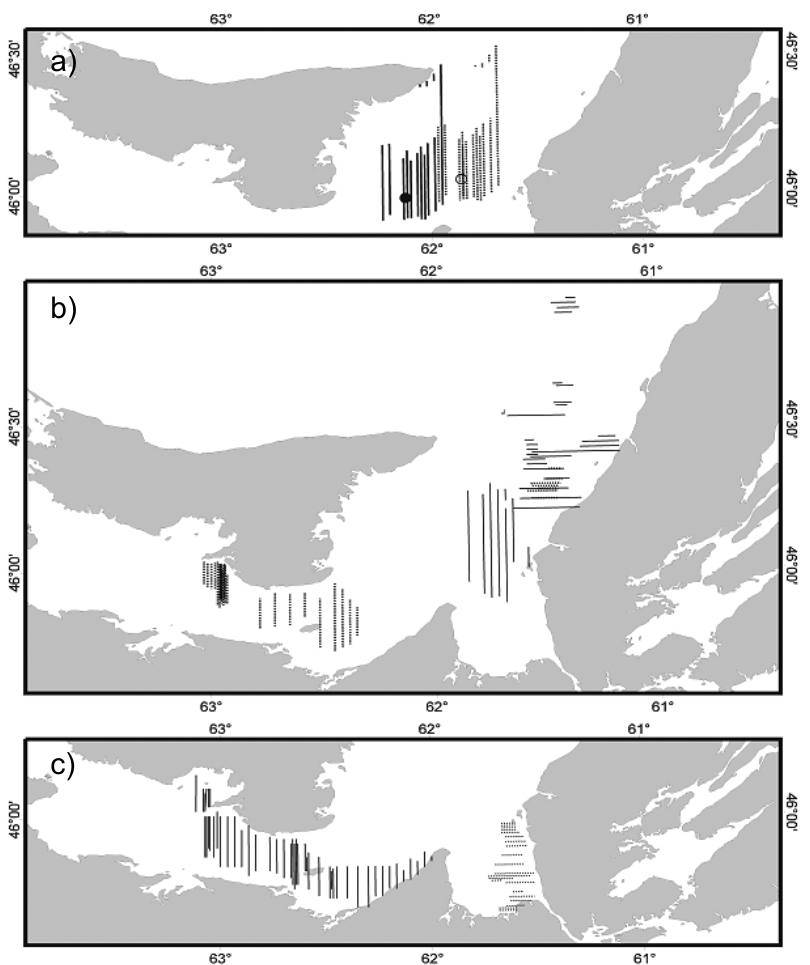
Fig.3. (a) Transects flown and position of VHF transmitter on 24 (solid lines, closed circle) and 26 January 1996 (dotted lines, open circle). (b) Transects flown on 26 and 27 January 1996 (respec - tively solid and dotted lines). (c) Transects flown on 2 and 9 Febru - ary 1996 (respectively in solid lines and dotted